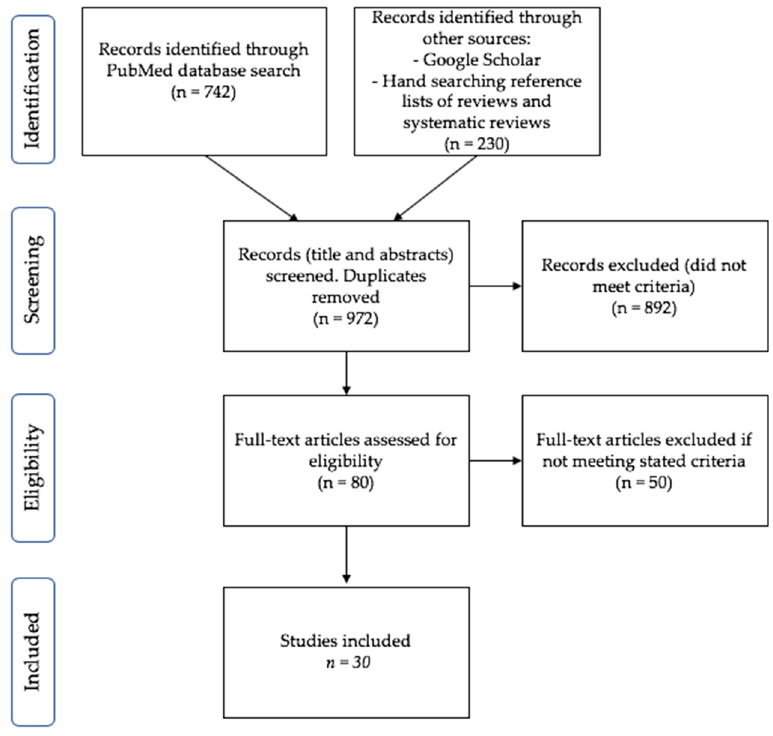
Figure 1. PRISMA diagram of research publication selection.